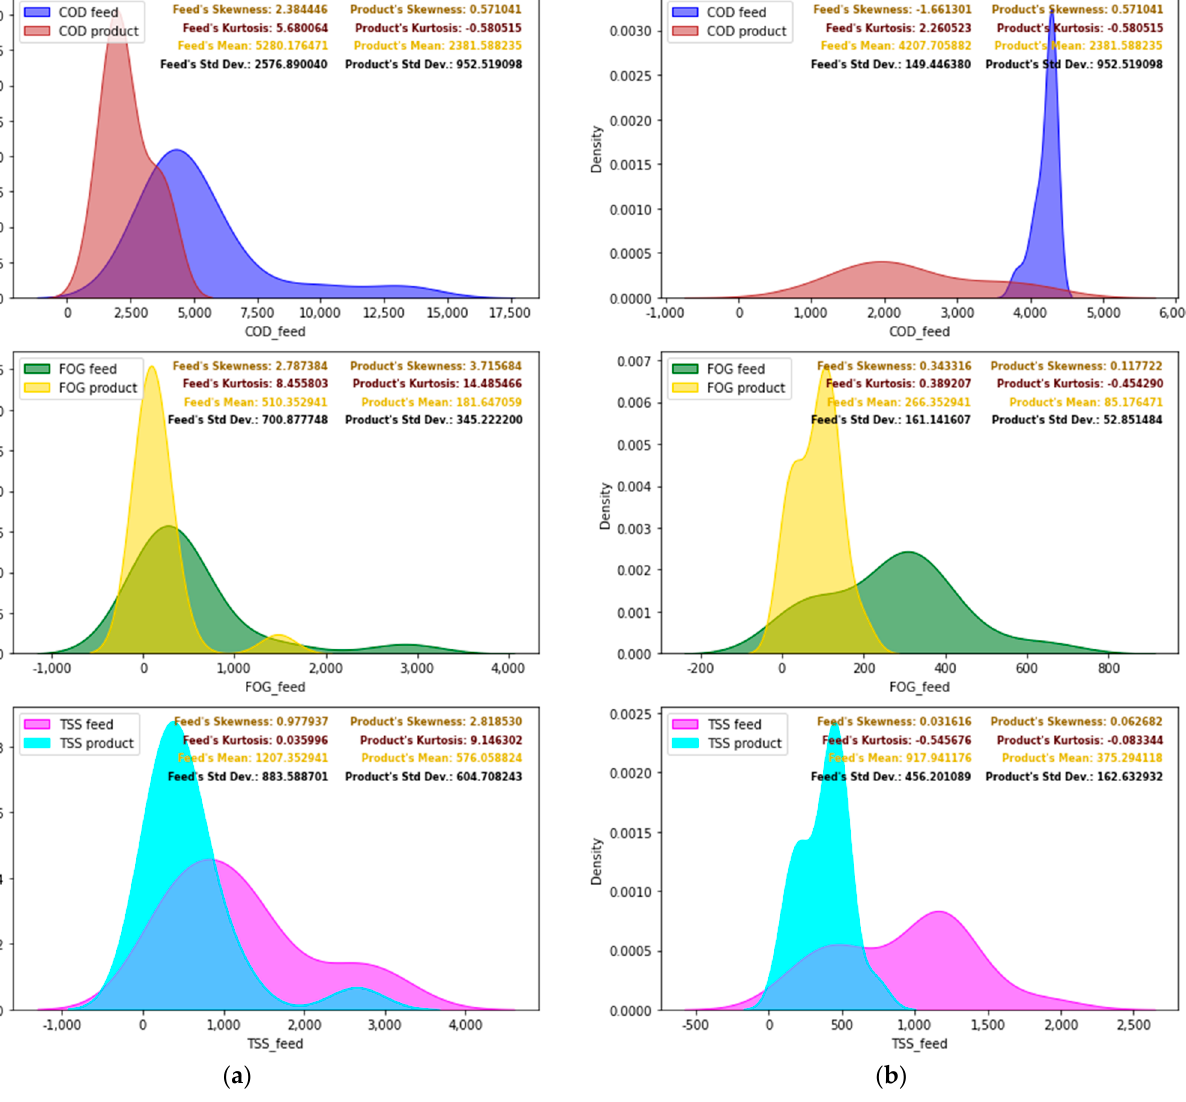
Figure 5. Pre-treatment probability density functions before anomaly detection and correction. ( a ) Probability density functions before anomaly correction. ( b ) Probability density functions after anomaly detection.